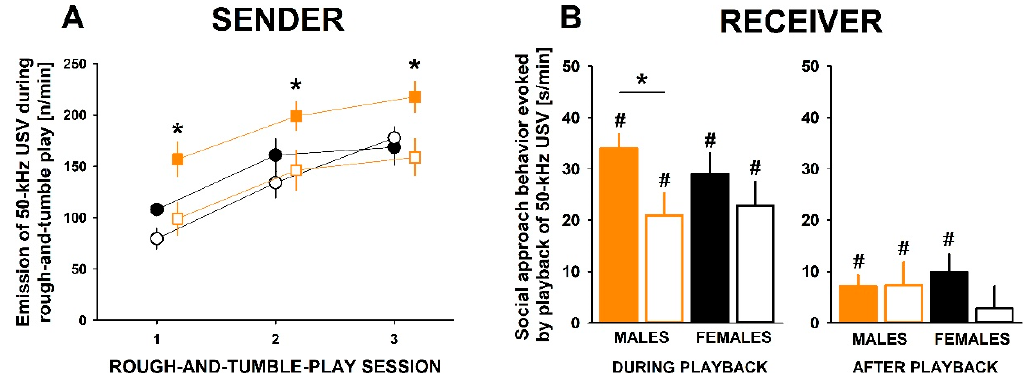
Figure 2. Effects of Cacna1c haploinsufficiency on ( A ) the emission of 50-kHz ultrasonic vocalizations (USV) emitted during rough-and-tumble play in the sender (filled orange squares = male Cacna1c +/+ littermate controls; open orange squares = male Cacna1c +/ − rats; filled black circles = female Cacna1c +/+ littermate controls; open white circles = female Cacna1c +/ − rats; N = 10 play pairs each) and ( B ) on social approach behavior evoked by playback of 50-kHz USV in the receiver (filled orange bars = male Cacna1c +/+ littermate controls; open orange bars = male Cacna1c +/ − rats; filled black bars = female Cacna1c +/+ littermate controls; open black bars = female Cacna1c +/ − rats; N = 20 rats each). Please note that social approach behavior is shown as change scores from baseline. Data were previously reported in [15,16]. * p < 0.05 vs. male Cacna1c +/+ littermate controls; # p < 0.05 vs. baseline.